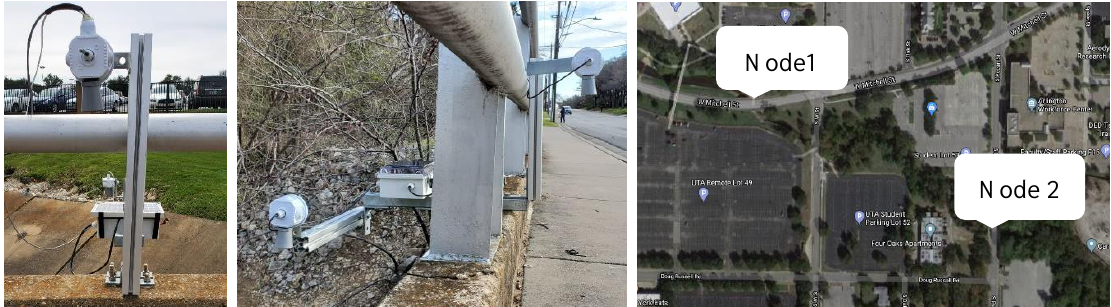
Figure 9. Installed units and locations: Node 1 ( left ), Node 2 ( middle ), and location map of two nodes ( right ).